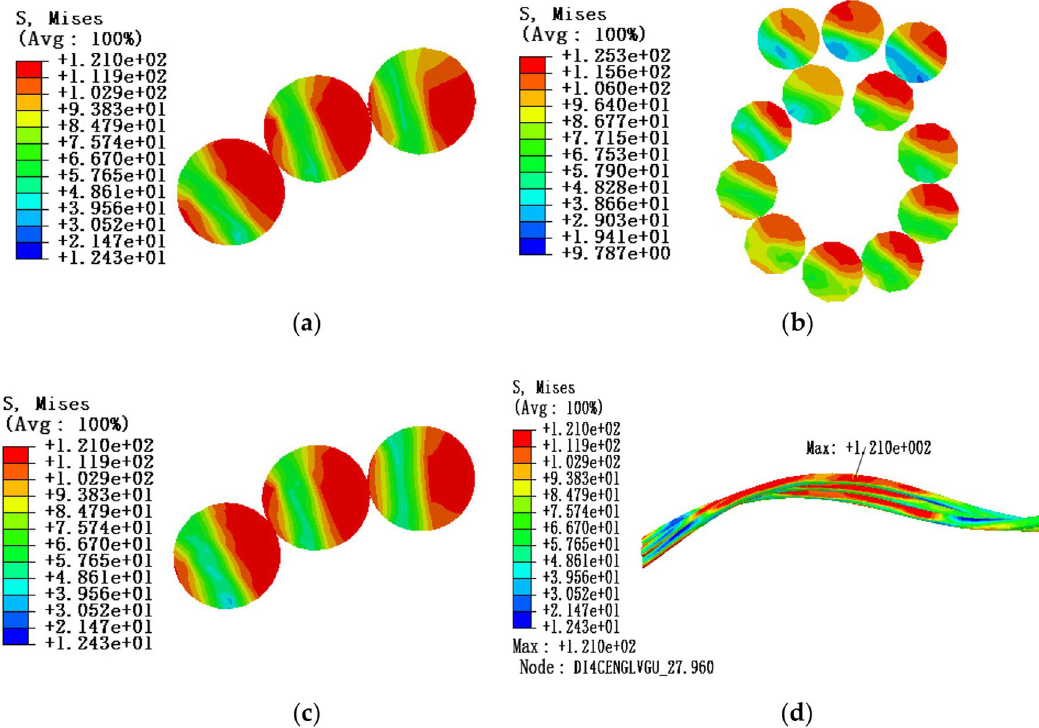
Figure 11. Equivalent stress cloud diagram of aluminum strand at 20% RTS ( a) Equivalent stress cloud diagram at maximum stress; ( b ) Equivalent stress cloud diagram at the middle point section; ( c ) Equivalent stress cloud diagram at 0.5 times the pitch diameter; ( d ) Overall equivalent stress cloud diagram of aluminum strand.